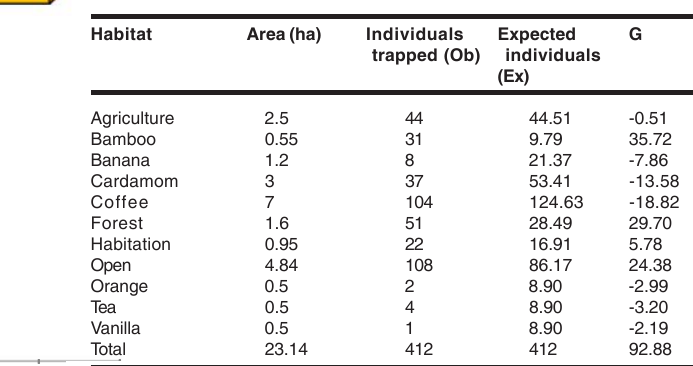
Table 5. Goodness of fit test for small mammal abundance in different habitats in